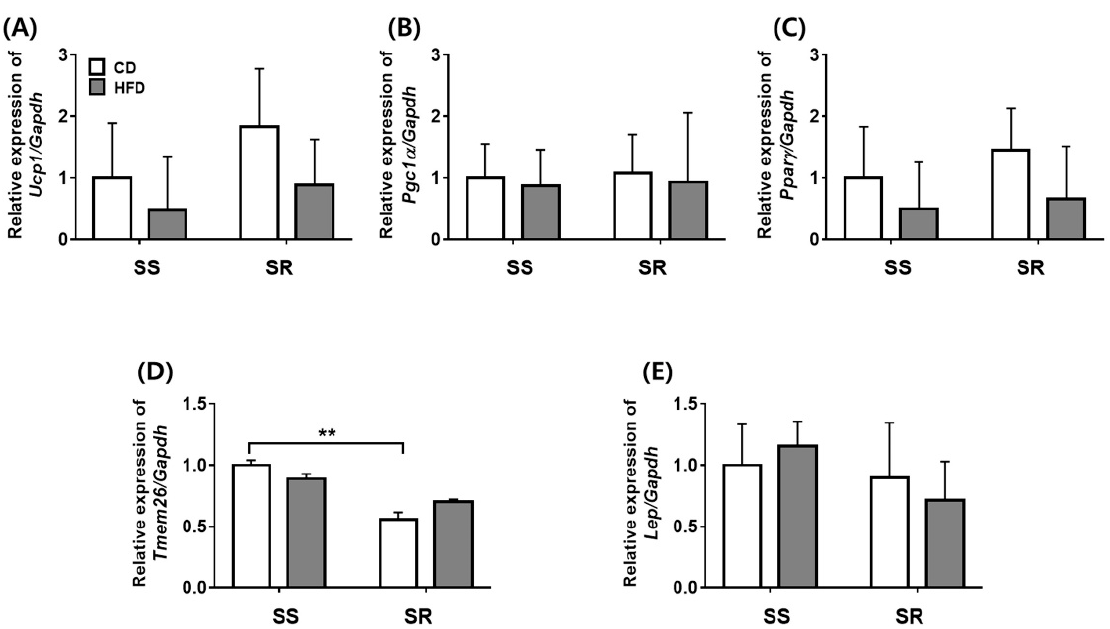
Figure 3. The effects of a high-fat diet on the expression of adipocyte marker genes in PVAT from SS and SR rats. The mRNA expression of brown adipocyte-related genes such as uncoupling protein 1 ( Ucp1 , A ), peroxisome proliferator-activated receptor γ coactivator 1- α ( Pgc-1 α , B ), and peroxisome proliferator-activated receptor γ ( Ppar γ , C ), a beige adipocyte-related gene such as transmembrane protein 26 ( Tmem26 , D ), and a white adipocyte-related gene such as Leptin ( E ) were measured by RT-qPCR in PVAT from SS and SR rats fed a CD or HFD for 12 weeks. Graph, mean ± SEM of 6 independent experiments. Two-way analysis of variance followed by Tukey’s post hoc multiple comparisons test. ** p < 0.01 vs. the SS CD group.